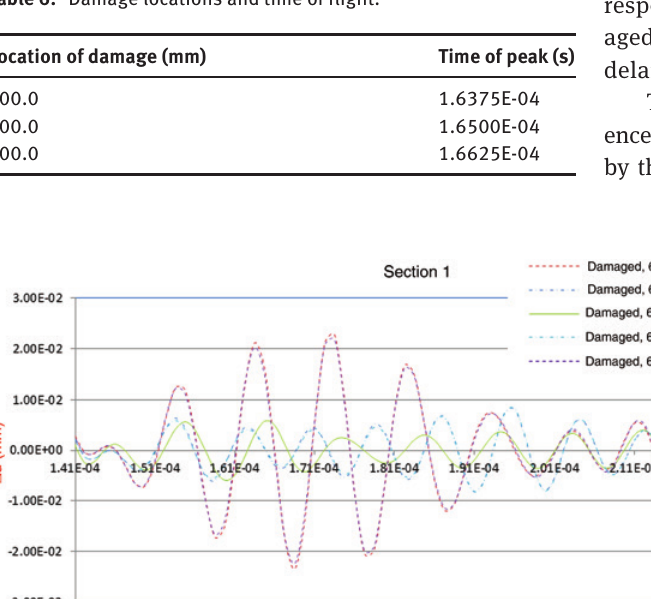
Table 6: Damage locations and time of flight.